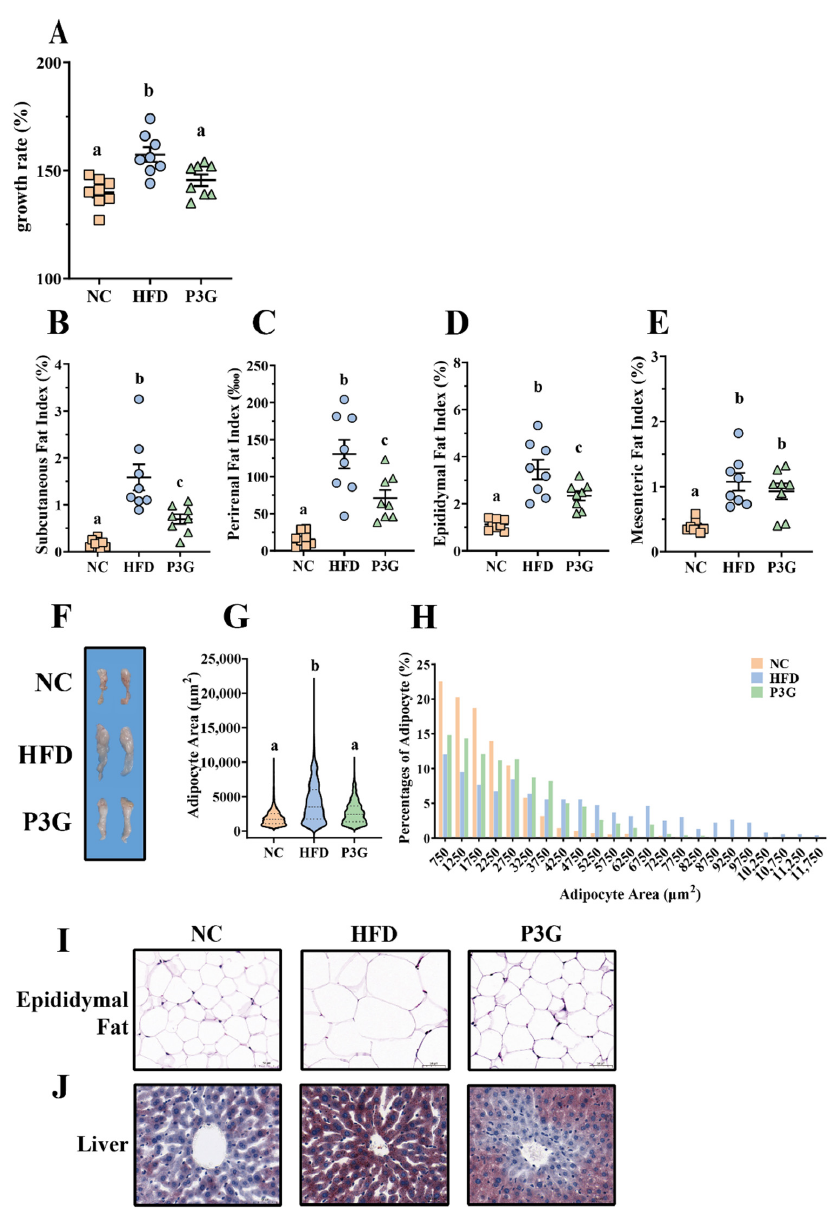
Figure 1. P3G supplementation reduced weight gain and fat accumulation in HFD-induced mice. Mice induced by high-fat diet were treated with P3G (100 mg/day/body weight) for 12 weeks (n = 6–8 in each group): ( A ) growth rate within 12 weeks; ( B ) subcutaneous fat index; ( C ) perirenal fat index; ( D ) epididymal fat index; ( E ) mesenteric fat index; ( F ) adipose tissue; ( G , H ) epididymal adipocyte size (adipocyte size was estimated using ImageJ software); ( I ) hematoxylin and eosin (H&E)-stained epididymal adipose tissue (scale bar, 100 μ m); ( J ) representative pictures of Oil Red O-stained liver tissue (scale bar, 100 μ m). Data are expressed as mean ± standard error (mean ± SEM) and analyzed using one-way analysis of variance (ANOVA); a, b, and c represent significant differences between groups. The same letter indicates no significance between the two groups, and different letters indicate significance ( p < 0.05).